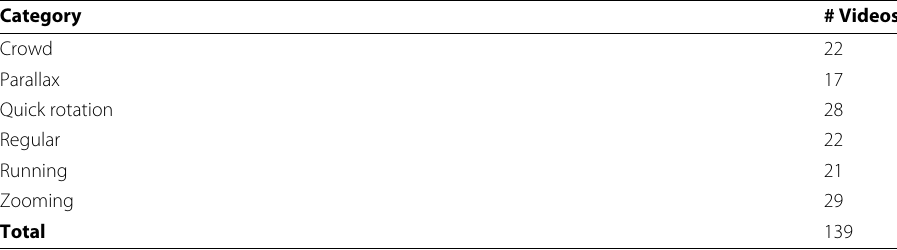
Table 2 Categories and amount of videos present in the second dataset, proposed by Liu et al. [30] Category